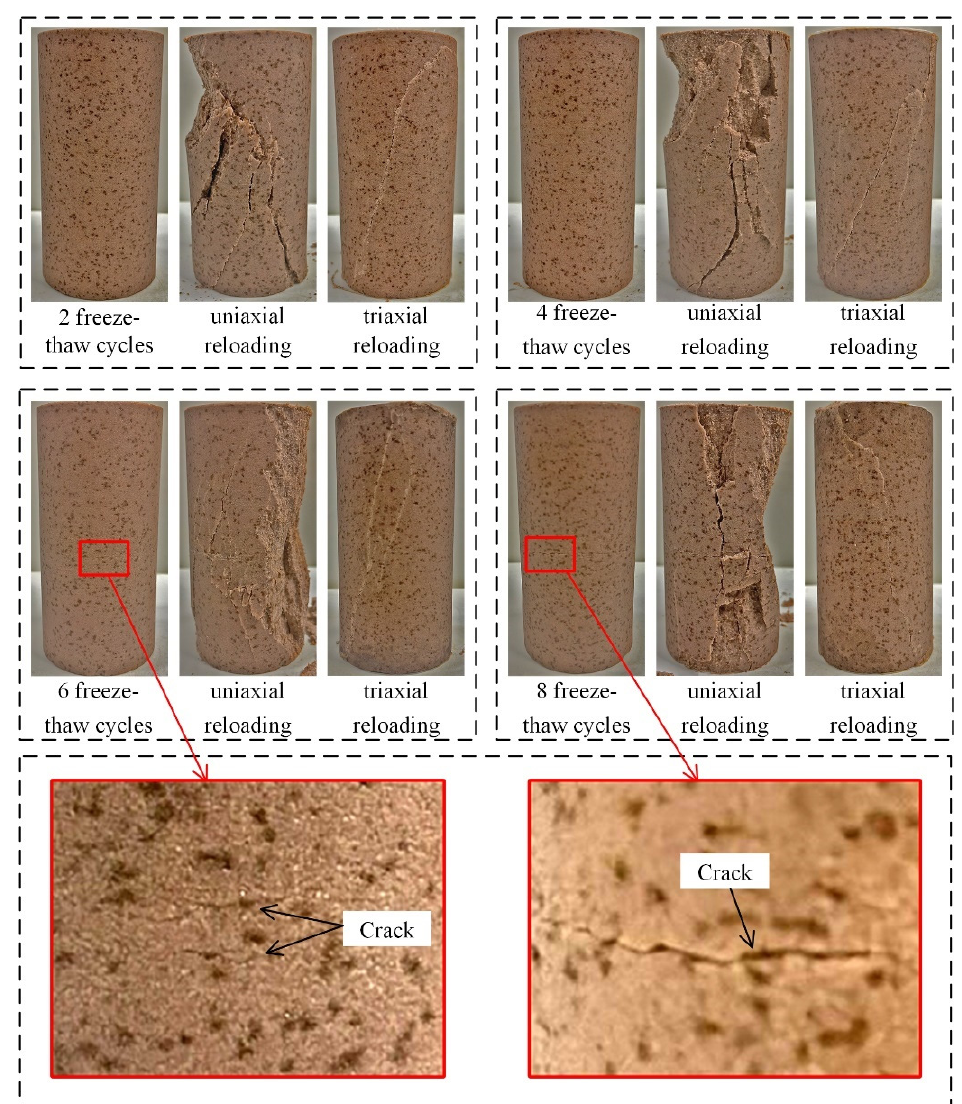
Figure 10. Damage characteristics of the unloaded-damaged samples after freeze-thaw cycles as well as uniaxial and triaxial reloading.